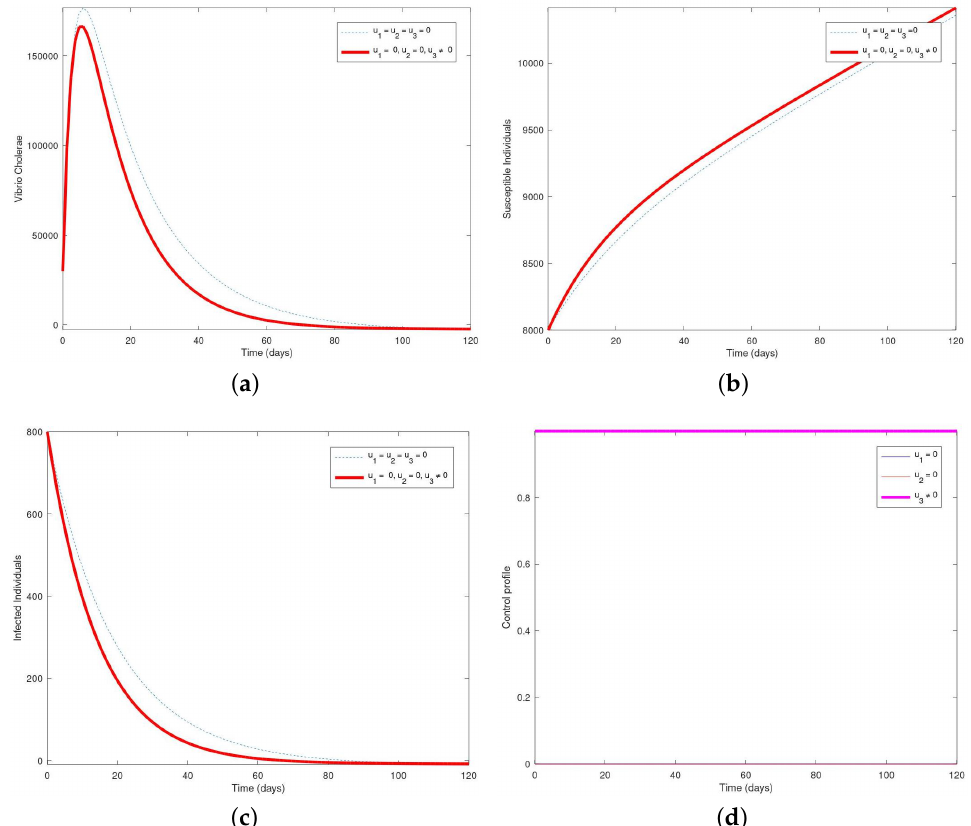
Figure 3. Simulation showing the population of ( a ) infected, ( b ) vibrio cholerae, ( c ) susceptible and ( d ) the control profile with ( u 3 ) only. In Figure 3a, it is observed that the population of vibrio cholerae increases slightly and then drops down completely after 80 days and the disease vanishes within 80–120 days. In Figure 3b the number of susceptible humans increases faster (with the control intervention) than without the control intervention. This implies that the control u 3 ( t ) does not decrease the number of susceptible. In Figure 3c, the number of infected human population decreases completely in day 70 and vanishes by day 120. In Figure 3d, the control profile shows that the control u 3 , remained constant from day 1 till the end of the 120 days while the others ( u 2 and u 3 ) maintained lower